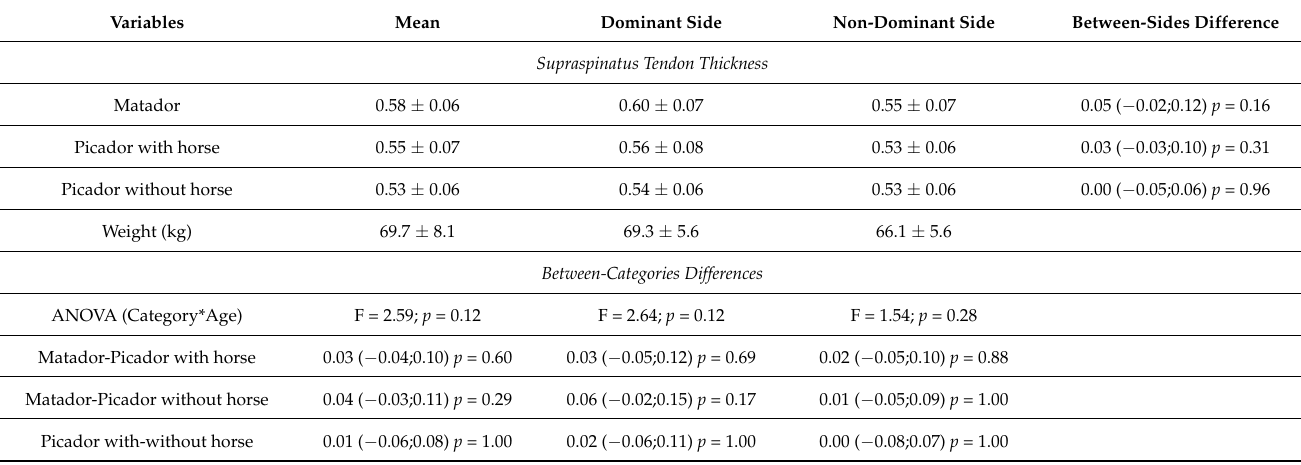
Table 3. Supraspinatus Tendon Ultrasonographic